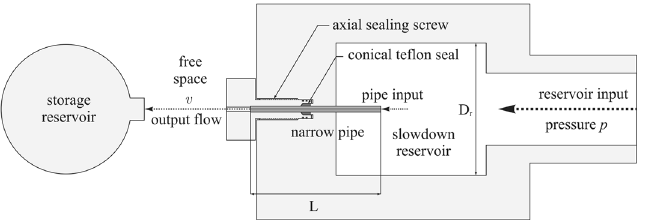
Figure 1. Scheme of the experiment. The pipe is placed in the middle of the slowdown reservoir and sealed by axial screw with teflon conical seal. We then observed the dependence of the cross-section speed v in narrow pipe on the pressure p of the fluid in reservoir.